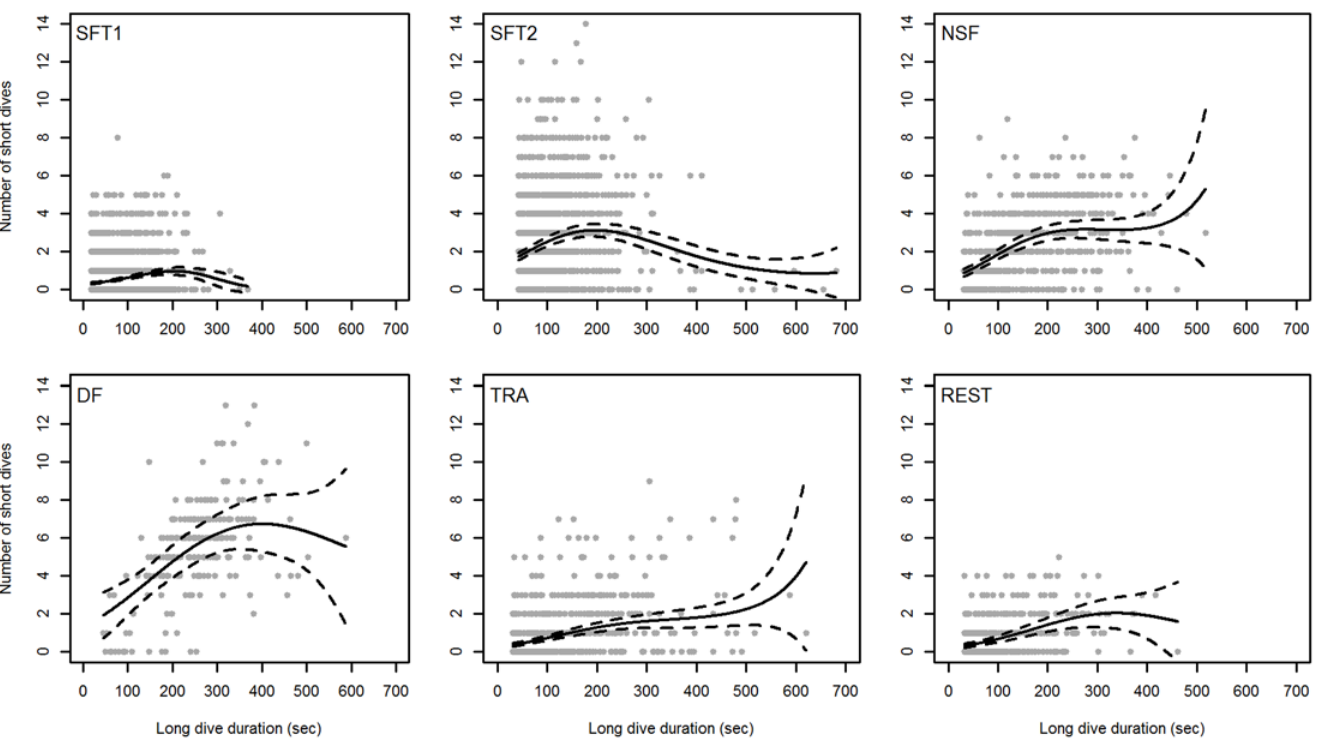
Fig 3. Back transformed number of short dives in a surfacing bout as a function of the dive duration of the preceding long dive for minke whales during different activity states. SFT1 = surface feeding tactic I, SFT2 = surface feeding tactic II, NSF = near-surface foraging, DF = deep foraging, TRA = traveling, REST = resting. The dashed lines represent 95% confidence interval (CI). The predicted values and CI were obtained using the AICcmodavg package in R. N = 6901.